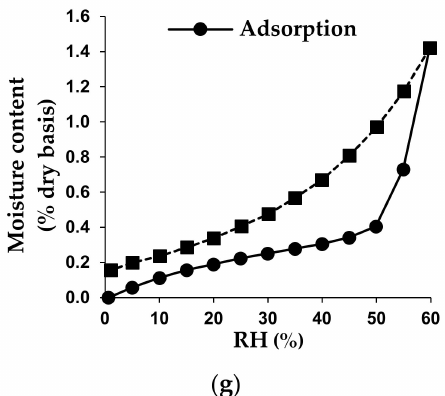
Figure 1. Moisture adsorption and desorption isotherms of green rooibos extract powder and powder mixtures at 25 ◦ C: ( a ) green rooibos extract powder (GRE) ( b ) IN50 (green rooibos extract microencapsulated with inulin in 1:1 (m/m) ratio), ( c ) M1 (IN50 and sucrose), ( d ) M2 (IN50 and xylitol), ( e ) M3 (IN50, xylitol and citric acid), ( f ) M4 (IN50, xylitol and ascorbic acid) and ( g ) M5 (IN50, xylitol, ascorbic and citric